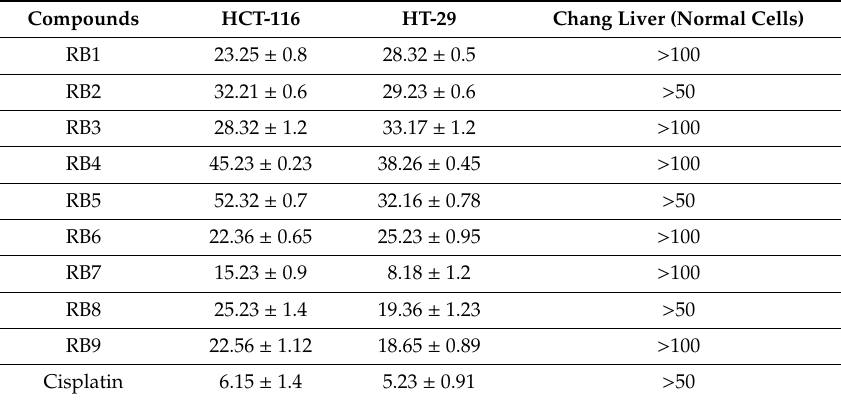
Table 1. IC 50 for Pyrazine